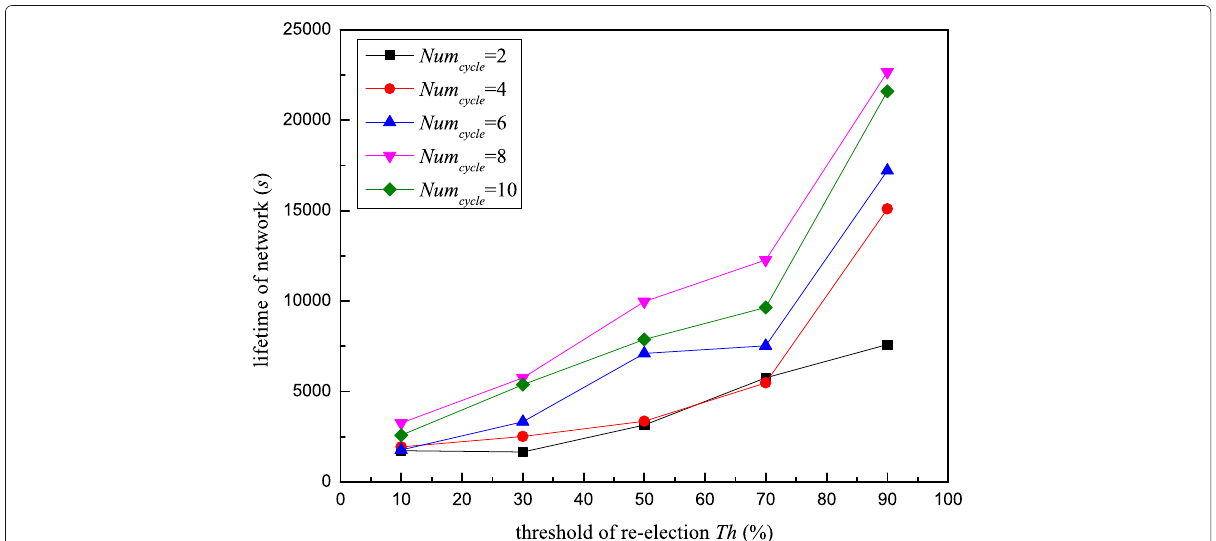
Fig. 9 The network lifetime under different system parameters (Th and Num cycle ). When Th was 90% and Num cycle was 8, the network lifetime could reach the maximum value